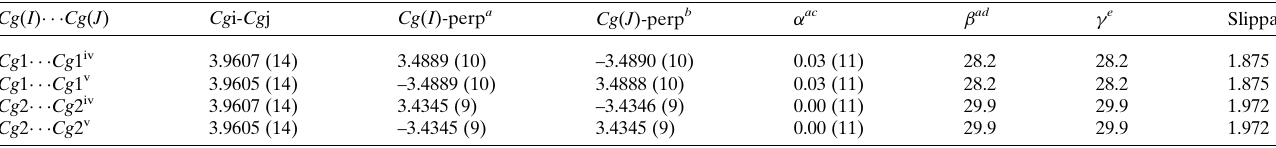
Table 3 (cid:2) – (cid:2) stacking geometry (A˚ , (cid:3) ). ( a ) perpendicular distance of Cg ( I ) on ring J ; ( b ) perpendicular distance of Cg ( J ) on ring I ; ( c ) dihedral angle between Planes I and J ; ( d ) angle between Cg ( I )– > Cg ( J ) vector and normal to plane I ; ( e ) angle between Cg ( I )–> Cg ( J ) vector and normal to plane J . Cg ( I ) (cid:2)(cid:2)(cid:2) Cg ( J )